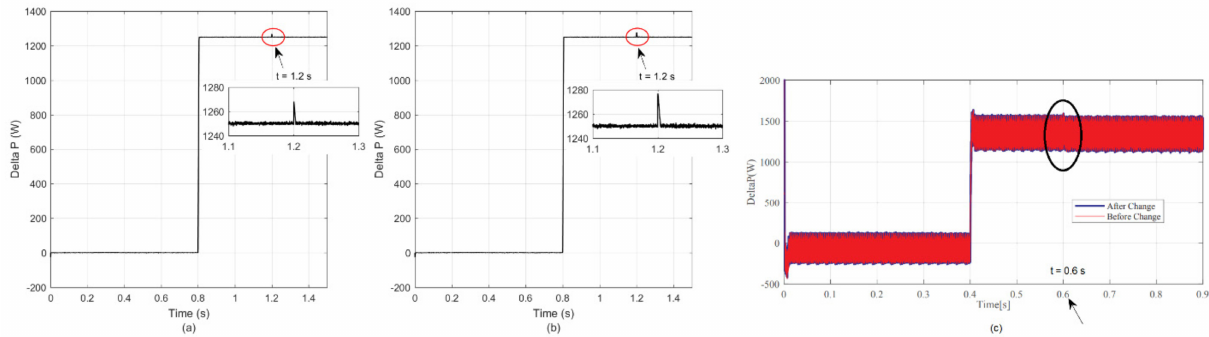
Figure 6. Variation of the active power of AC-MG compensated by inverter 2, ( a ) with the first set of MG parameters, ( b ) with the second set of MG parameters, and ( c ) with two various sets of MG parameters in reference [19].